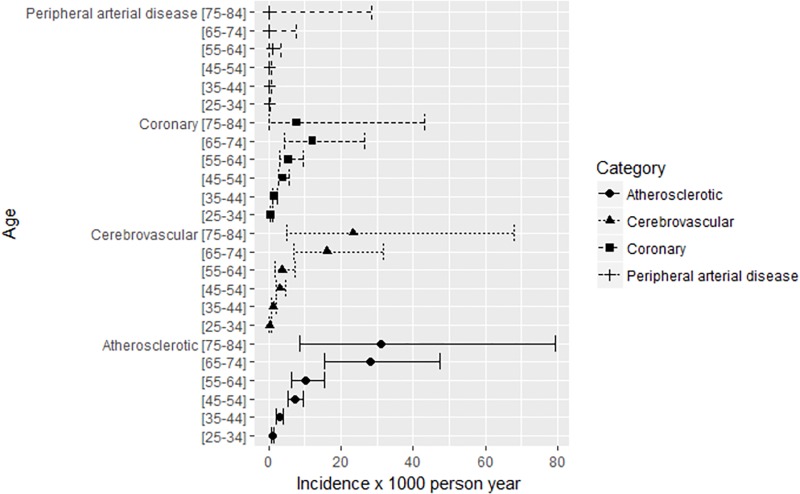
Incidence rates of vascular events by category and by age group, 2004–2015.